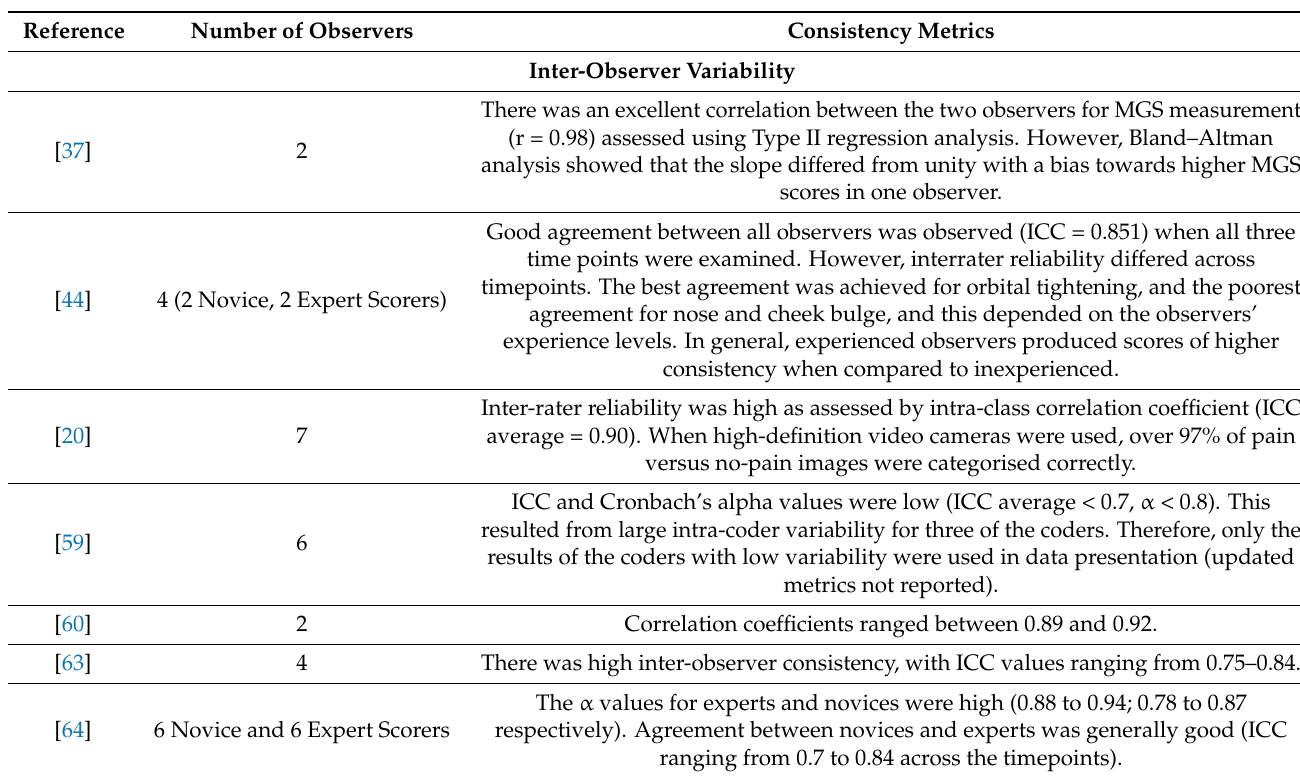
Table 4. Consistency metrics reported in the included studies. Inter-observer and inter-laboratory analyses were